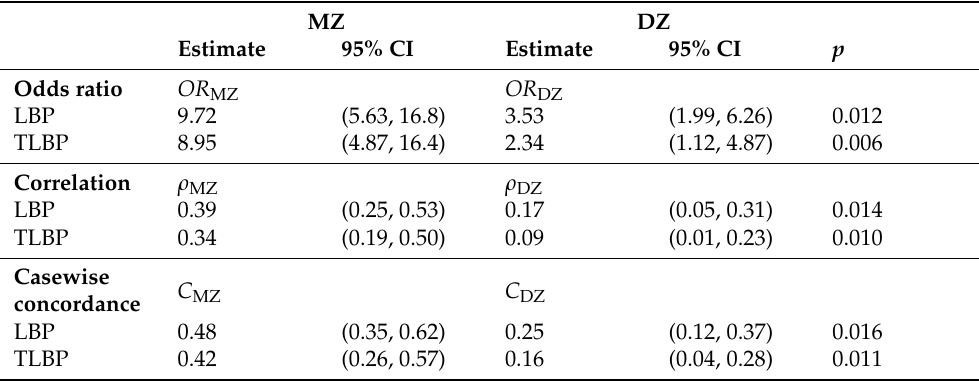
Table 4. Twin pair associations for LBP (life) and TLBP (current) using three measures; odds ratio ( OR ), correlation ( ρ ), and casewise concordance ( C ) (N = 651 twin pairs), for MZ and DZ pairs, and statistical significance ( p ) for the difference in association by zygosity.